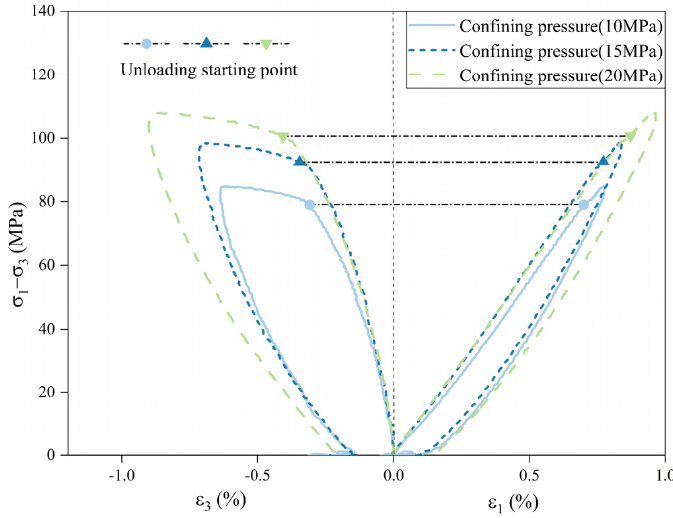
Figure 7. Sample unloading damage stress-strain curve.